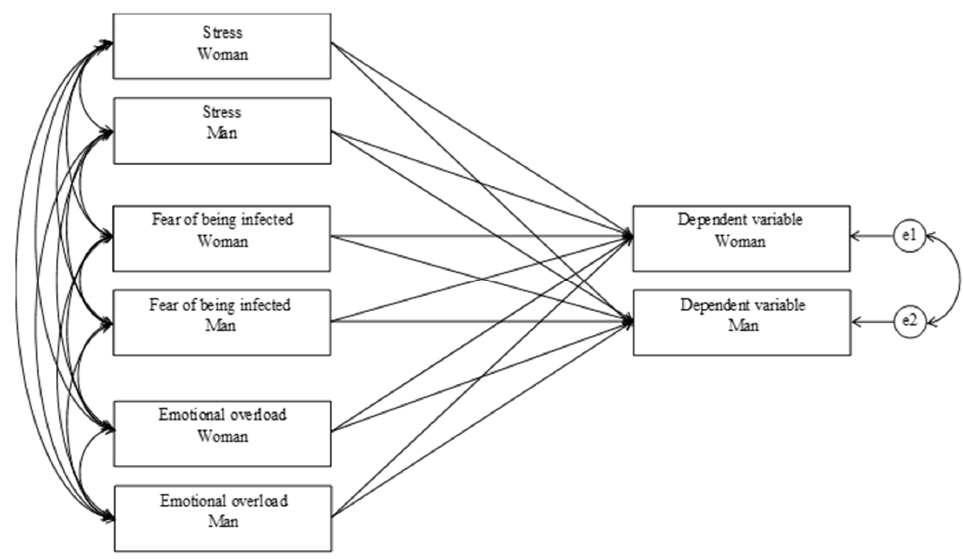
Figure 1. The APIMs tested for six different dependent variables: amused, anxiety, annoyance, sym- pathy, empathy, and parental responsiveness. sympathy, empathy, and parental